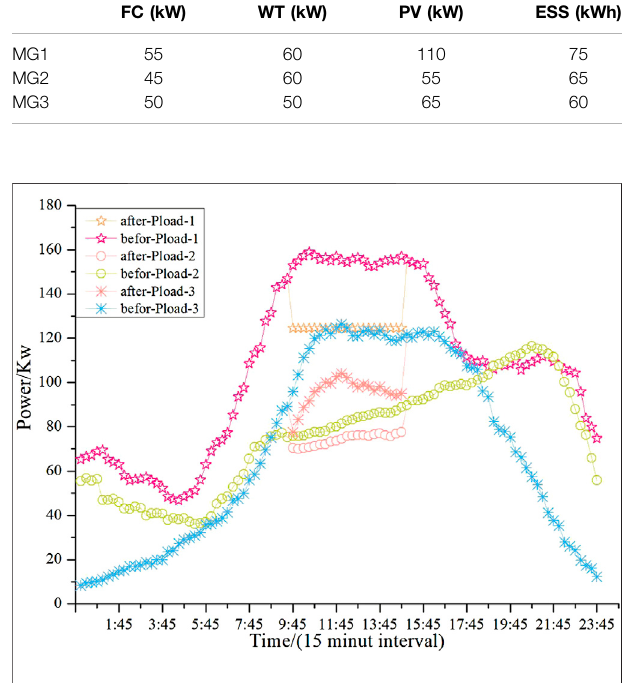
FIGURE 6 | Flexible load curtailment